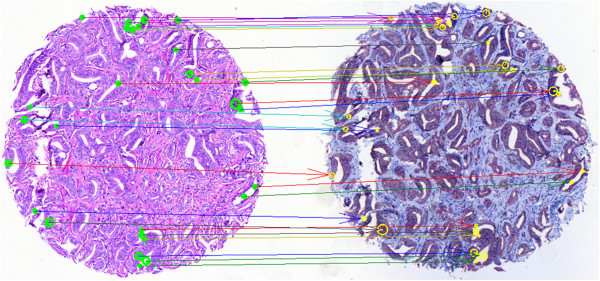
Successful alignment of H&E (left) and p63/AMACR (right). Initial keypoints ≈ 1000 in each image, preliminary matches = 34, best inliers = 31. The arrows link the matching inliers on the two images after rotation and scaling of the right image. In a perfect alignment the arrows would be parallel. This, however, is unrealistic in practice.